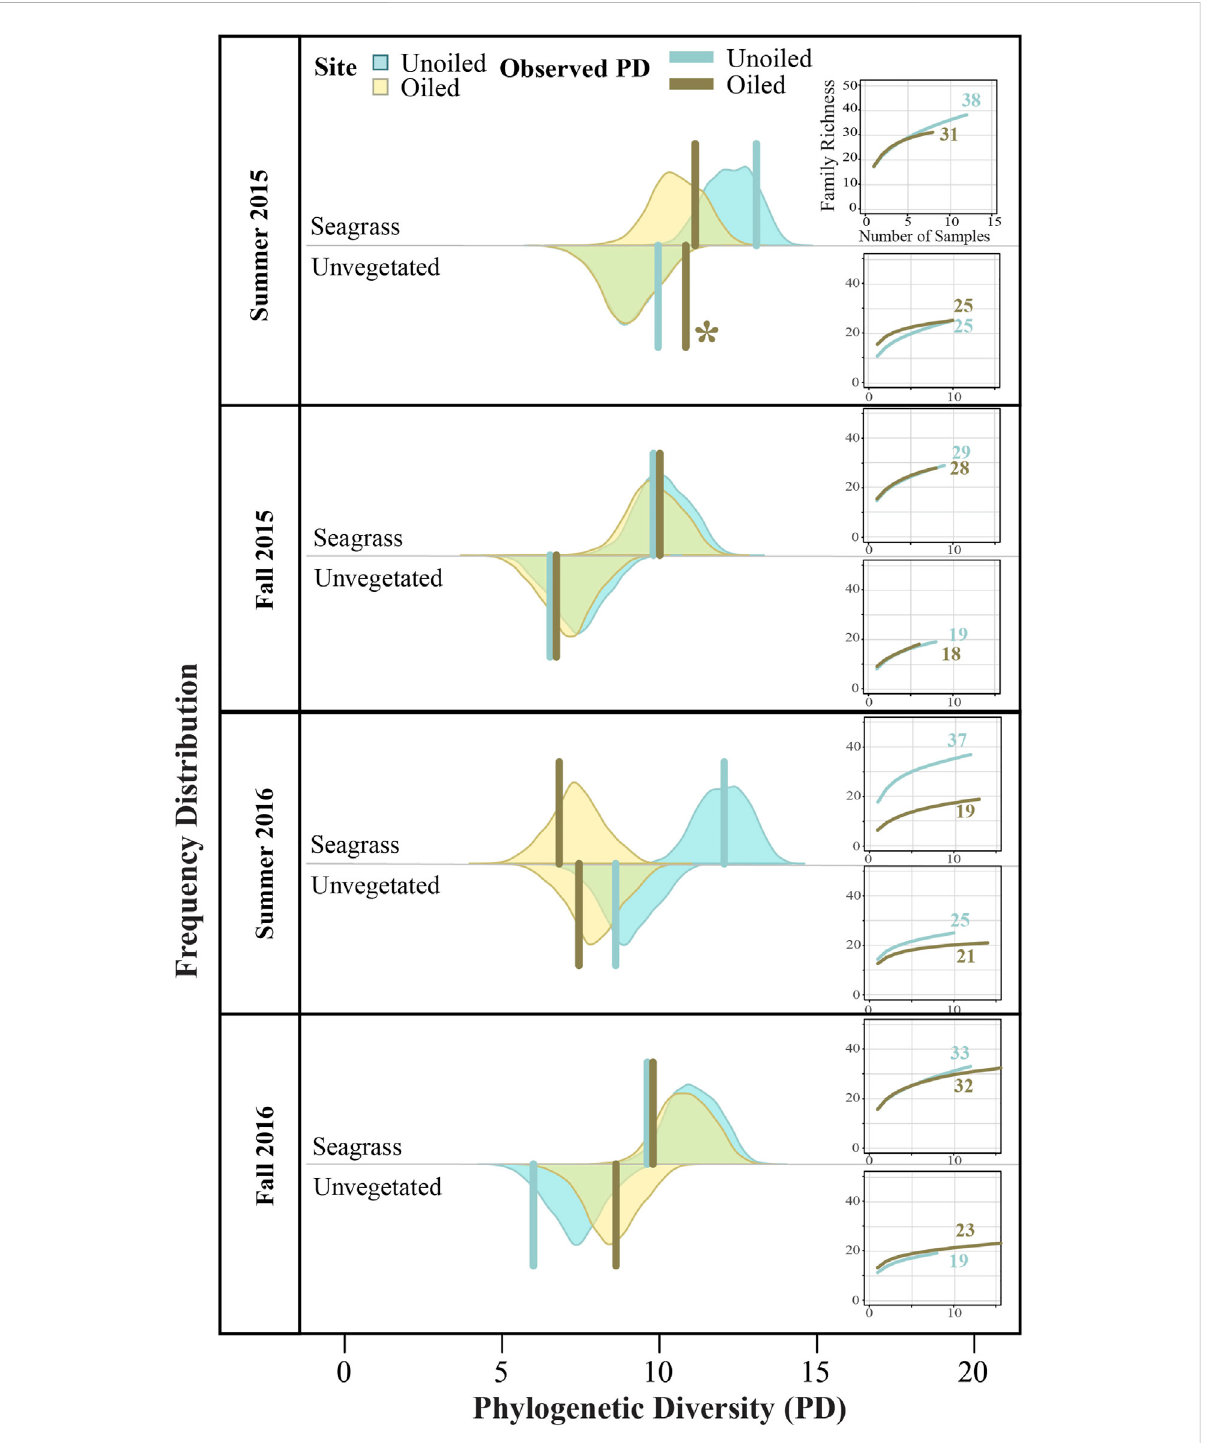
FIGURE 4 Observed community tree phylogenetic diversity (PD; solid bars) compared to null distributions (shaded areas) of PD values for the observed family richness generated for each season, year and habitat type for both sites. The asterisk (*) indicates signi fi cantly lower community PD than expected using one-tailed p -values calculated as the proportion of the null distribution ≤ PD observed (Table 1). Sample-based rarefaction curves and associated values of family richness are also shown for each site by sampling effort. Shaded colors are transparent, green shading indicates overlap of yellow and blue